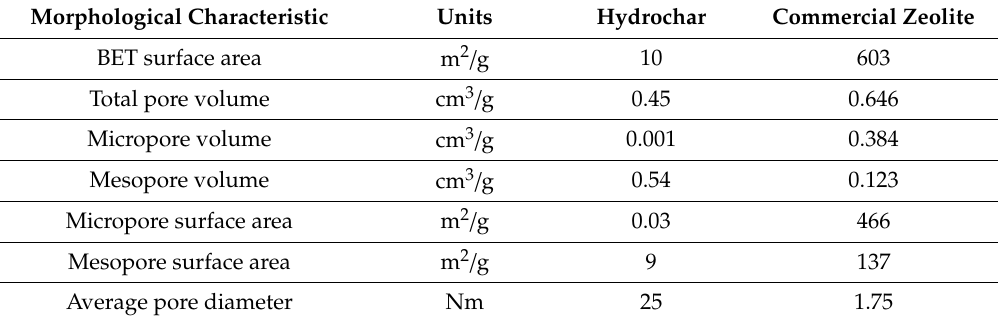
Table 3. Surface morphology